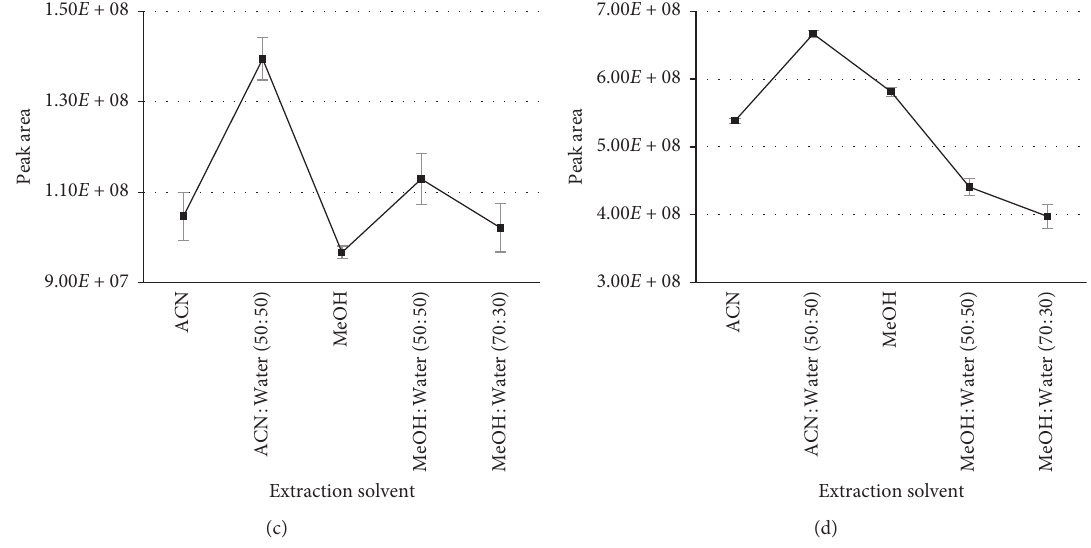
Figure 2: Comparison of the intensity of four representative PDE-5i with different extraction solvents. (a) Acetildenafil. (b) Acetaminotadalafil. (c) Hydroxyvardenafil. (d)